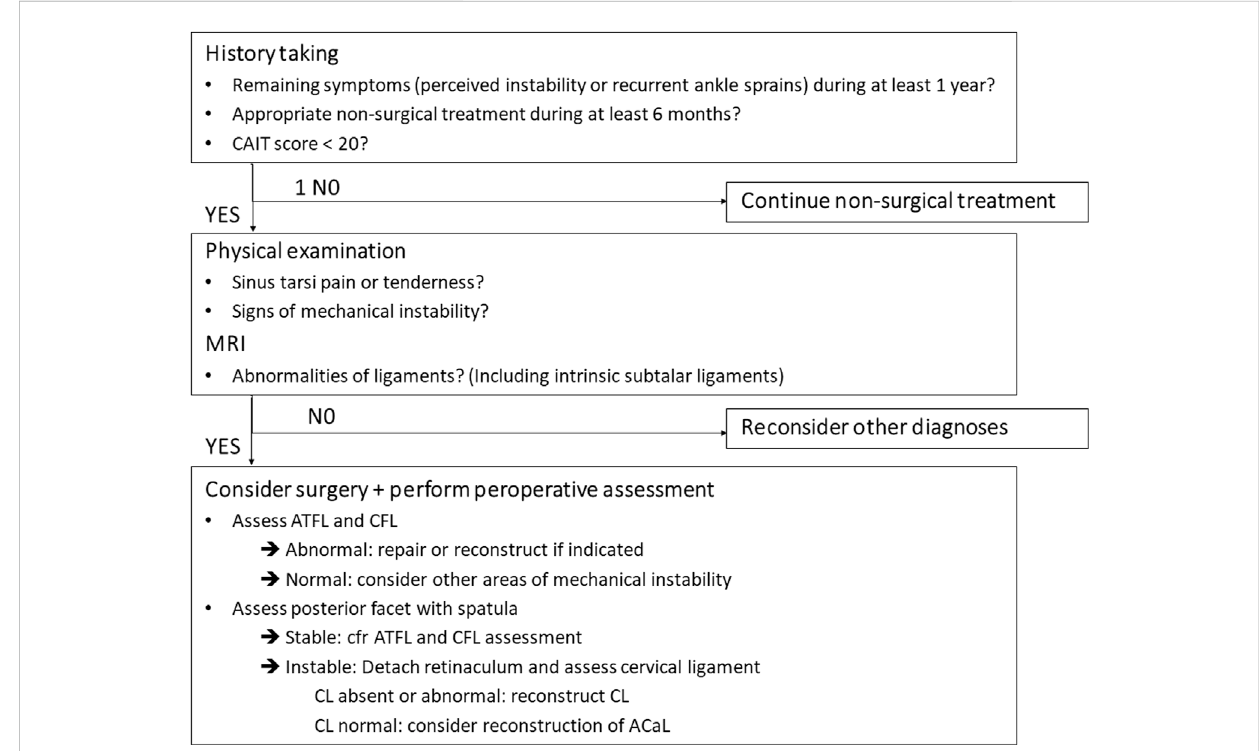
FIGURE 6 Algorithm (Figure 1 in Foot and Ankle Surg 2022 June. 10.1016/j.fas. 2022.06.006, no permission needed).